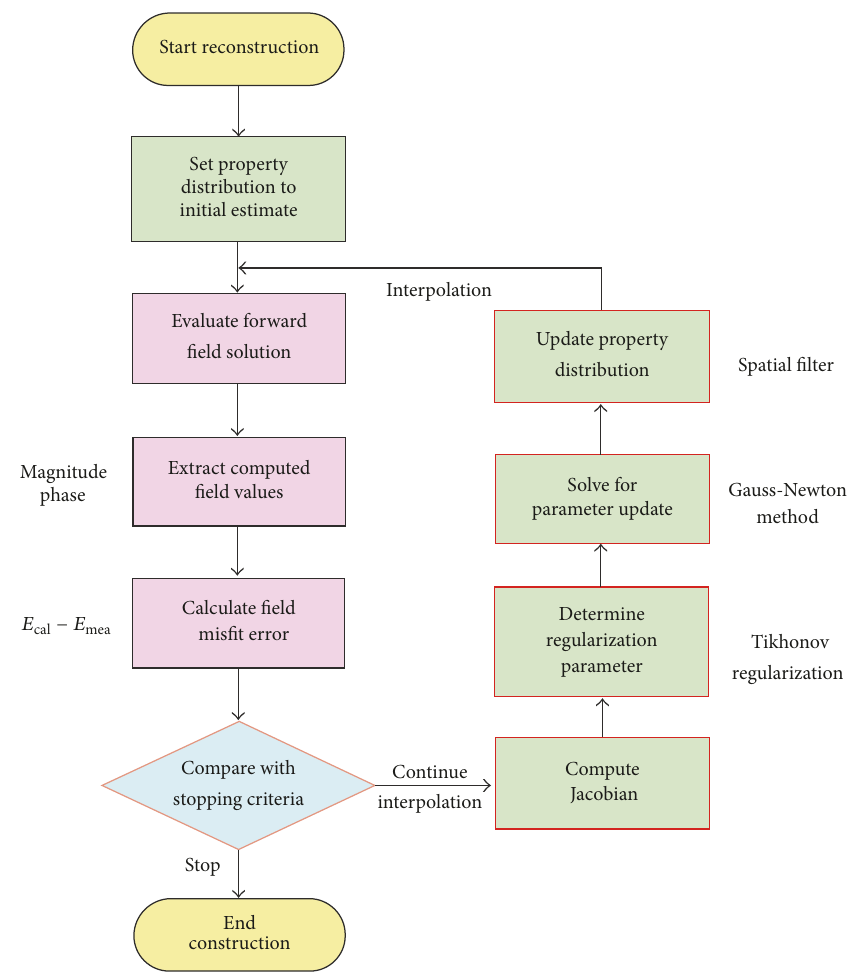
Figure 12: Flow chart of the ETRI reconstruction algorithm [21]. Image copyright ETRI, used with